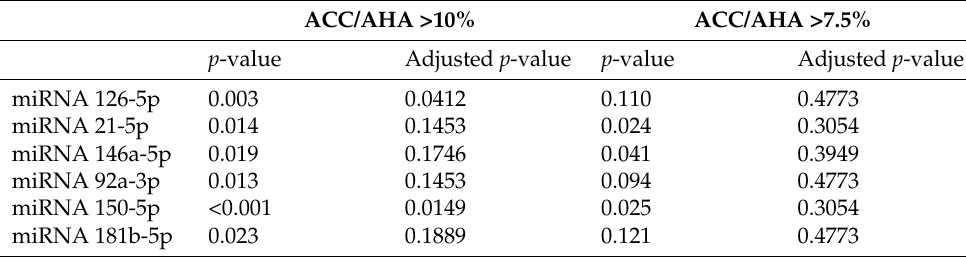
Table 4. Association of miRNA levels with the cardiovascular risks estimated by